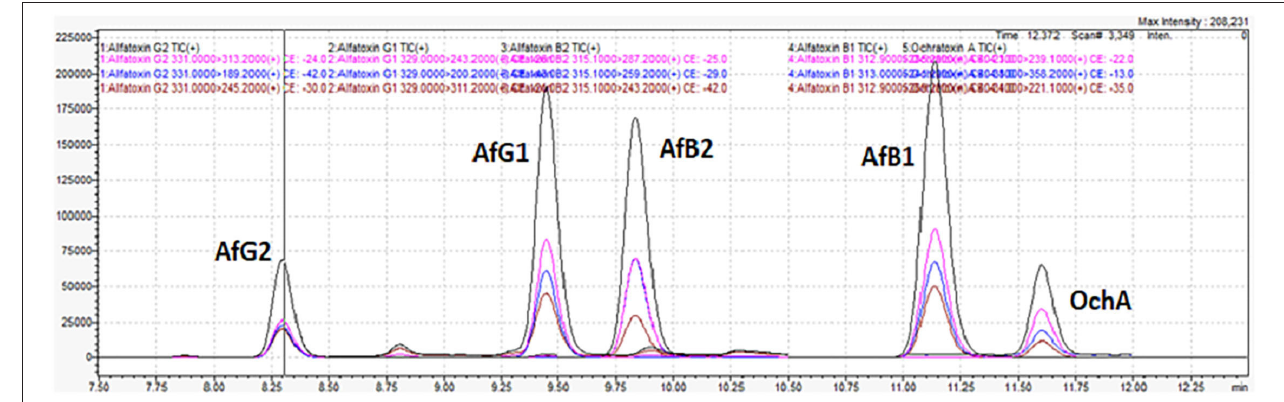
FIGURE 7 | Chromatogram of cannabis extract obtained from cannabis floss spiked with MRL for aflatoxins (2 µ g/kg) and ochratoxin A (20 µ